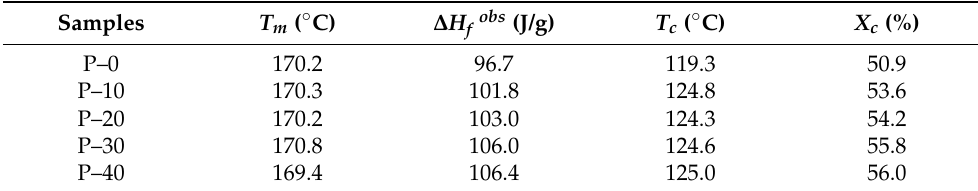
Figure 2. DSC curves of PP–g–PHMG/PP–blended monofilaments with different PP–g–PHMG con- tents under ( a ) heating and ( b ) cooling; ( c ) the dependence of crystallinity on PP–g–PHMG content. Table 2. T m , ∆ H f obs , T c , and X c of PP–g–PHMG/PP